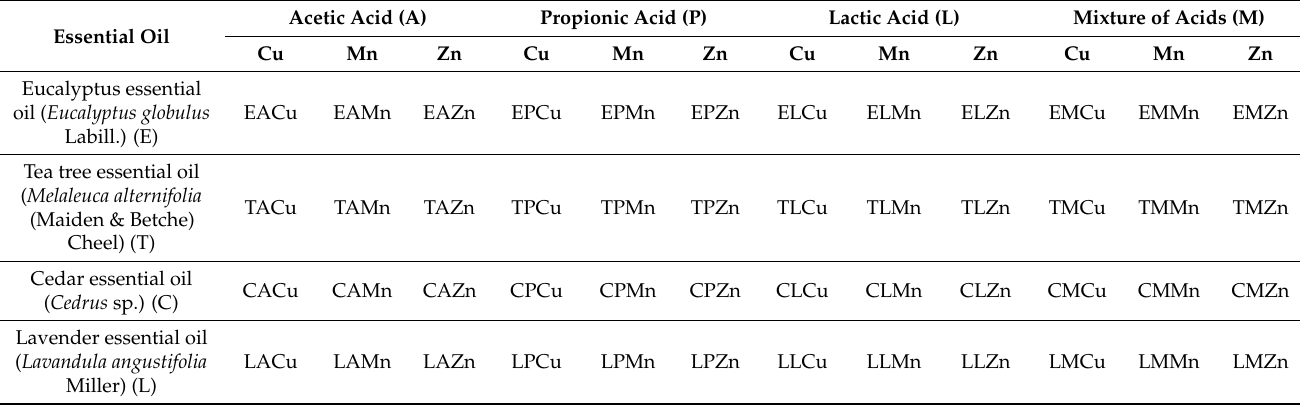
Table 1. Combinations obtained during the